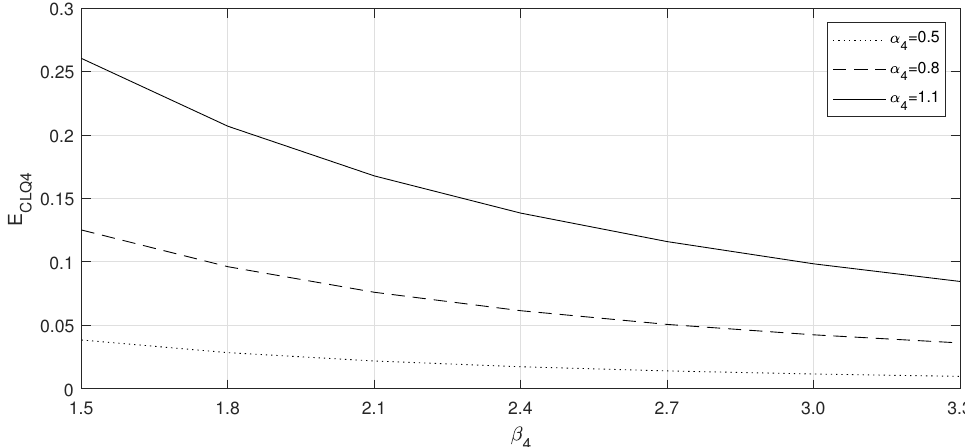
Figure 8. Expected customer loss in Queue-4 on β 4 vs. α 4 .